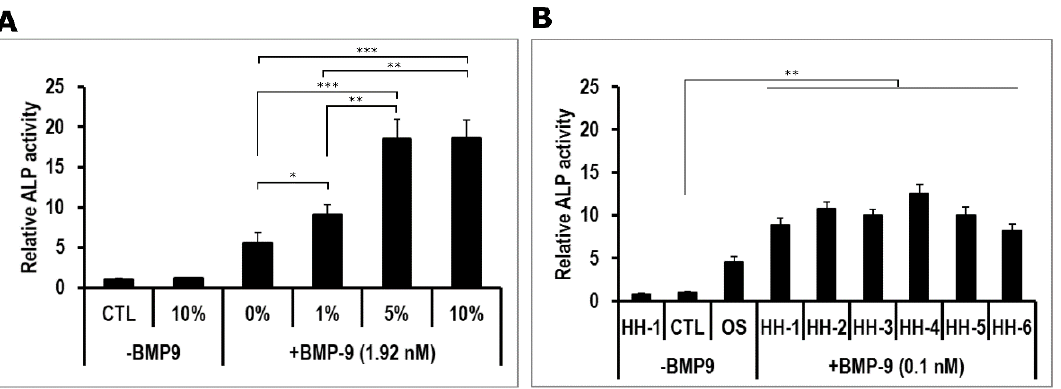
Figure 2. ( A ) Dose-response effect of healthy human serum (HH-1) on ALP activity in hmrSCs incubated for 3 days with or without 1.92 nM BMP9. Results are mean ± SEM of 4 independent experiments performed in triplicate. ( B ) Comparison of several HH (5% v / v ) on ALP activity in hmrSCs incubated for 3 days with or without 0.1 nM BMP9. Results are mean ± SEM of 4 independent experiments performed in triplicate. * p < 0.05, ** p < 0.01, *** p < 0.001.